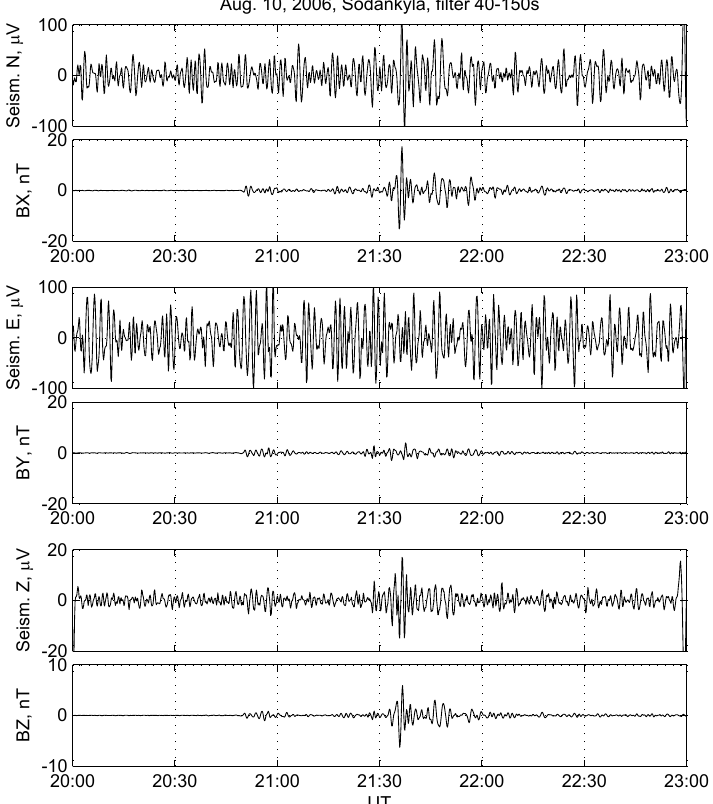
Fig. 3. An example of Pi2 geomagnetic pulsations during magnetic substorm recorded by co-located magnetometer and STS-2 seismometer in Sodankyl¨a. The 3-components (north, east, and vertical) of the seismometer output and corresponding components of magnetogram are filtered by the same band-pass filter at